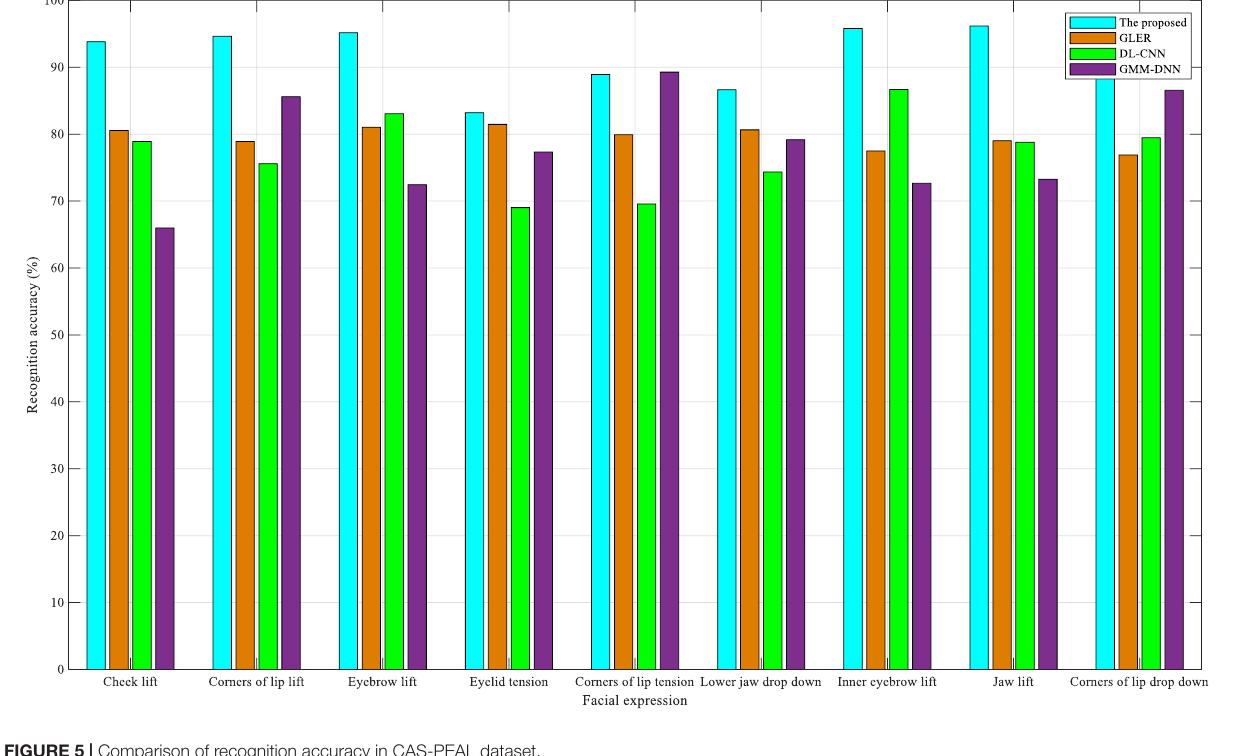
FIGURE 5 | Comparison of recognition accuracy in CAS-PEAL dataset.